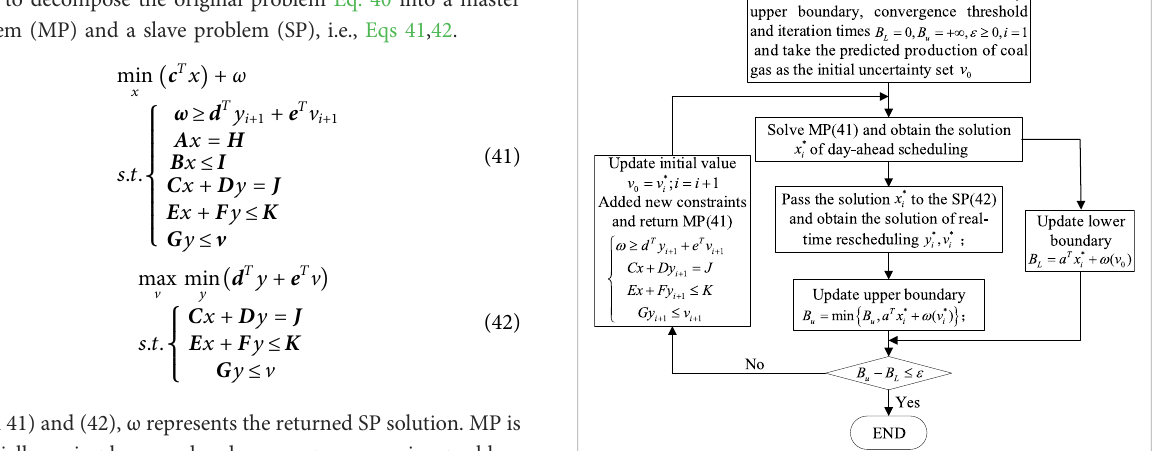
FIGURE 4 Flow chart of the CC&G